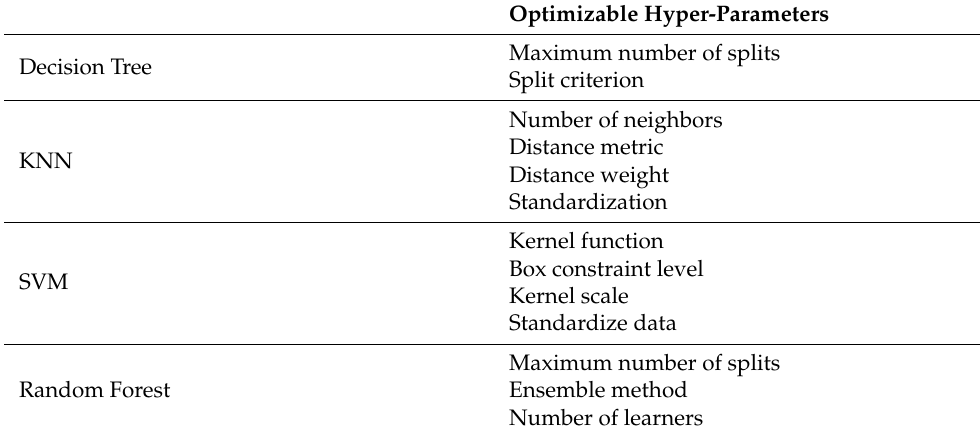
Table 1. Optimizable Parameters for Prediction